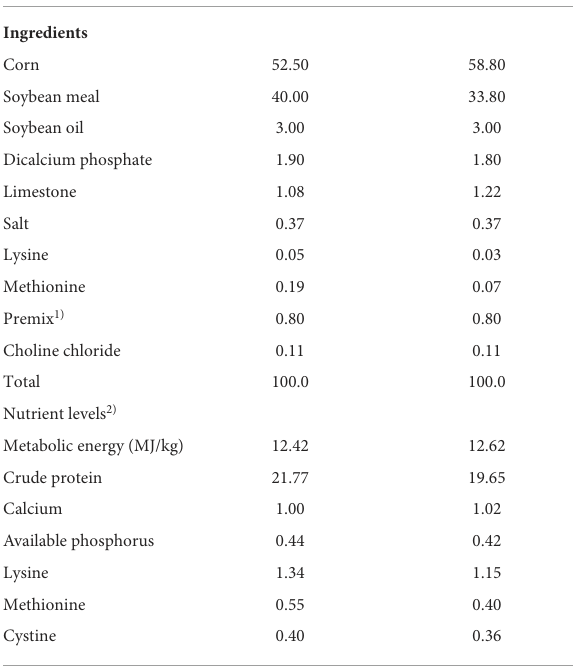
TABLE 1 Composition and nutrient levels of the basal diet (as-fed basis), %.